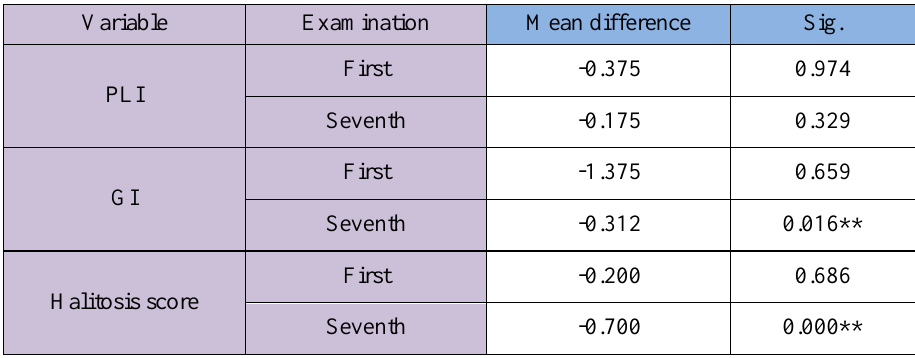
Scheffe test for compound comparison